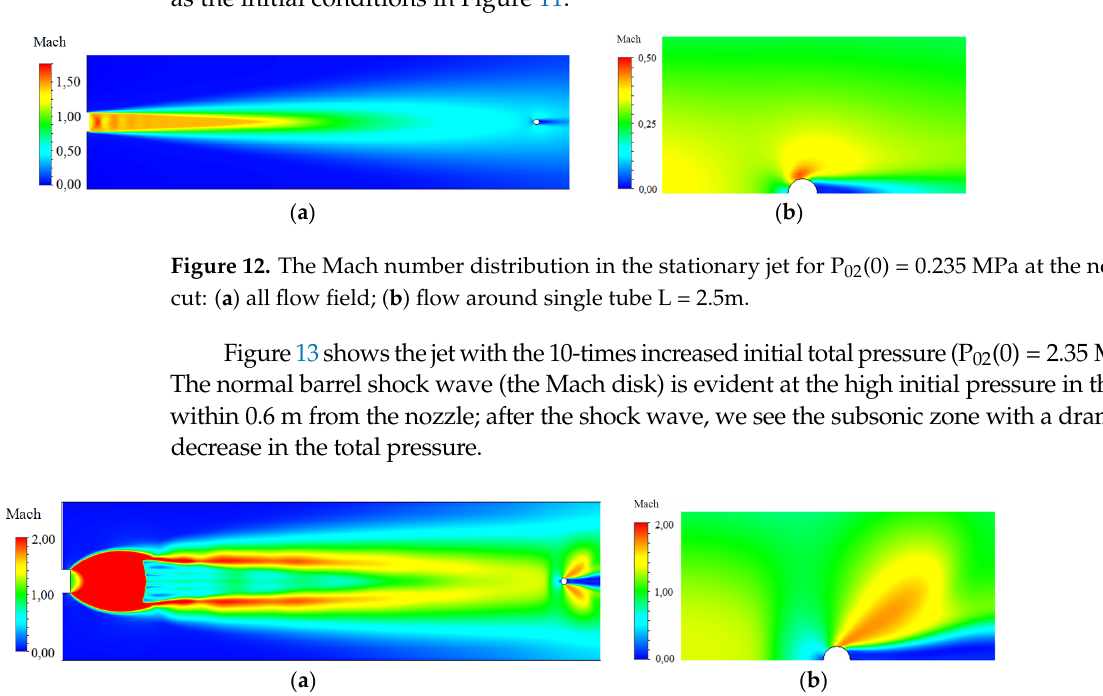
Figure 13. The Mach number distribution in the stationary jet for Р 02 (0) = 2.35 MPa at the nozzle cut: ( a ) all flow field; ( b ) flow around single tube L = 2.5m. Total pressure and Mach number distribution in the cross sections of the stationary jet within different distances from the nozzle are shown in Figures 14 and 15.